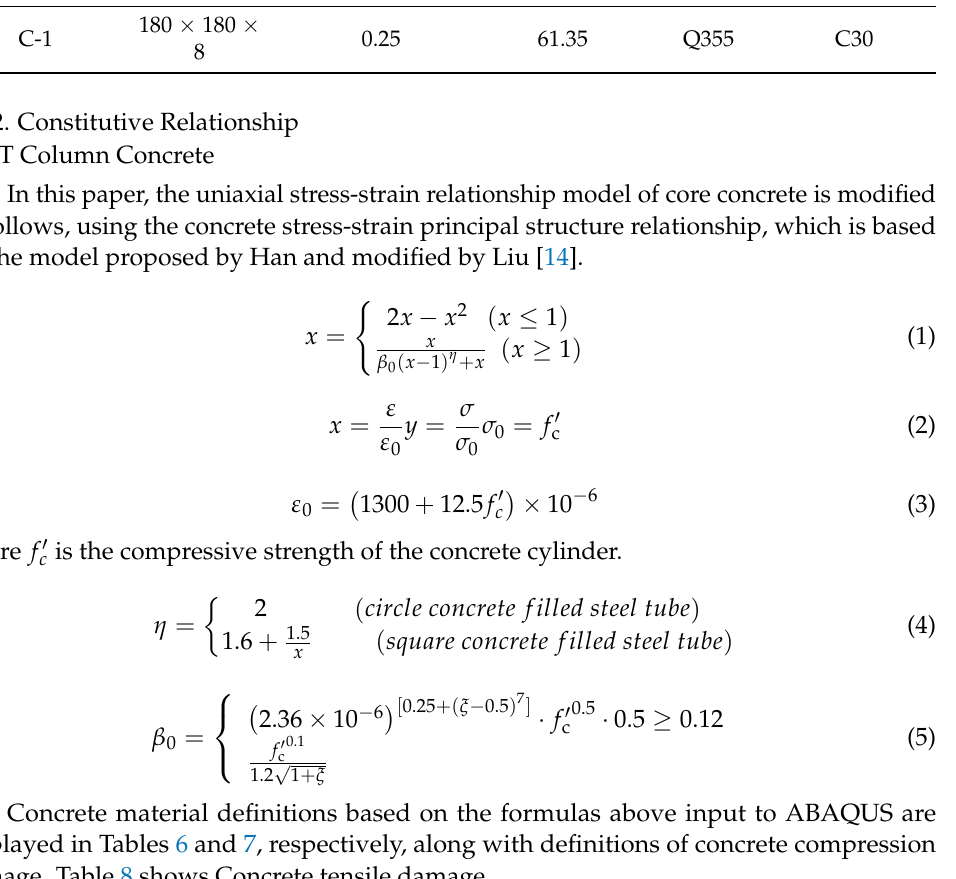
Table 6. Concrete basic parameters.